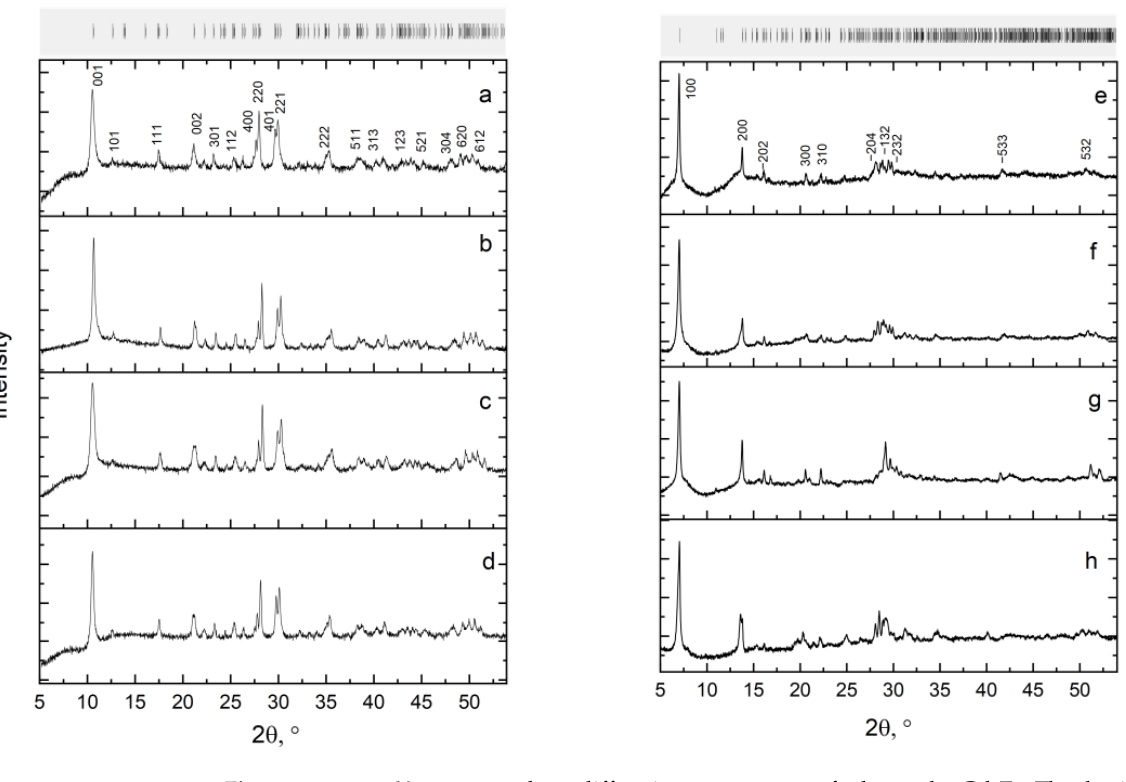
Figure 2. X-ray powder diffraction patterns of layered Gd-Eu-Tb basic chlorides: ( a ) Eu 2 (OH) 5.13 Cl 0.87 · n H 2 O, ( b ) Gd 2 (OH) 5 Cl · n H 2 O, ( c ) Tb 2 (OH) 4.9 Cl 1.1 · n H 2 O, ( d ) (Gd 0.17 Eu 0.45 Tb 0.38 ) 2 (OH) 5.08 Cl 0.92 · n H 2 O, and ( e – h ) products of their interaction with an aqueous solution of potassium 4-sulfobenzoate at 120 ° С after 24 h.